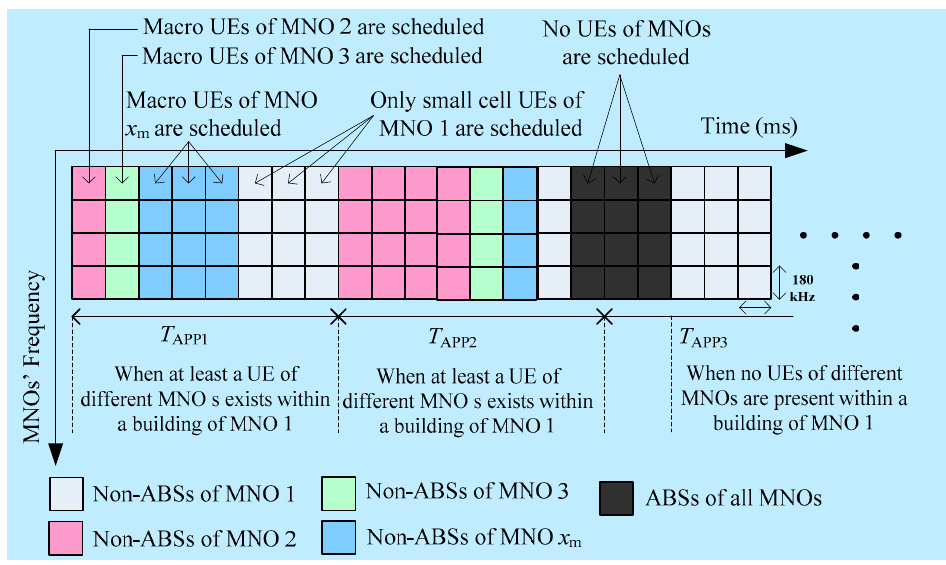
Figure 5. CCI avoidance using ABS based eICIC technique for small cells of MNO 1 in a building [12].